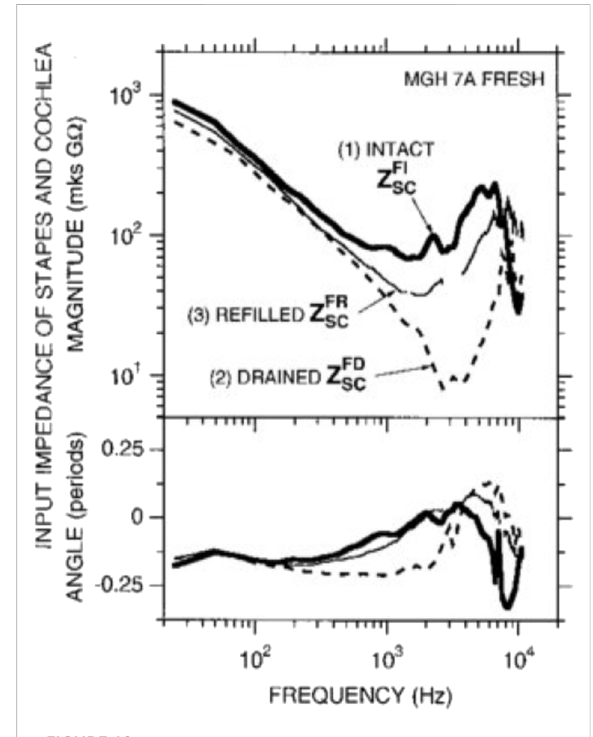
FIGURE 12 Input impedance of the stapes and cochlea decreases in magnitude and angle with drainage of the cochlea, demonstrating that inner ear fl uidplays a crucial role in thetransmission ofsound. Interestingly, re fi lling the cochlea allows regaining input impedance angle but not magnitude. Thus cochlear fl uid contributes predominantly as a resistive element to the ear input impedance. Reprinted with permission from Ravicz, M. E, et al.